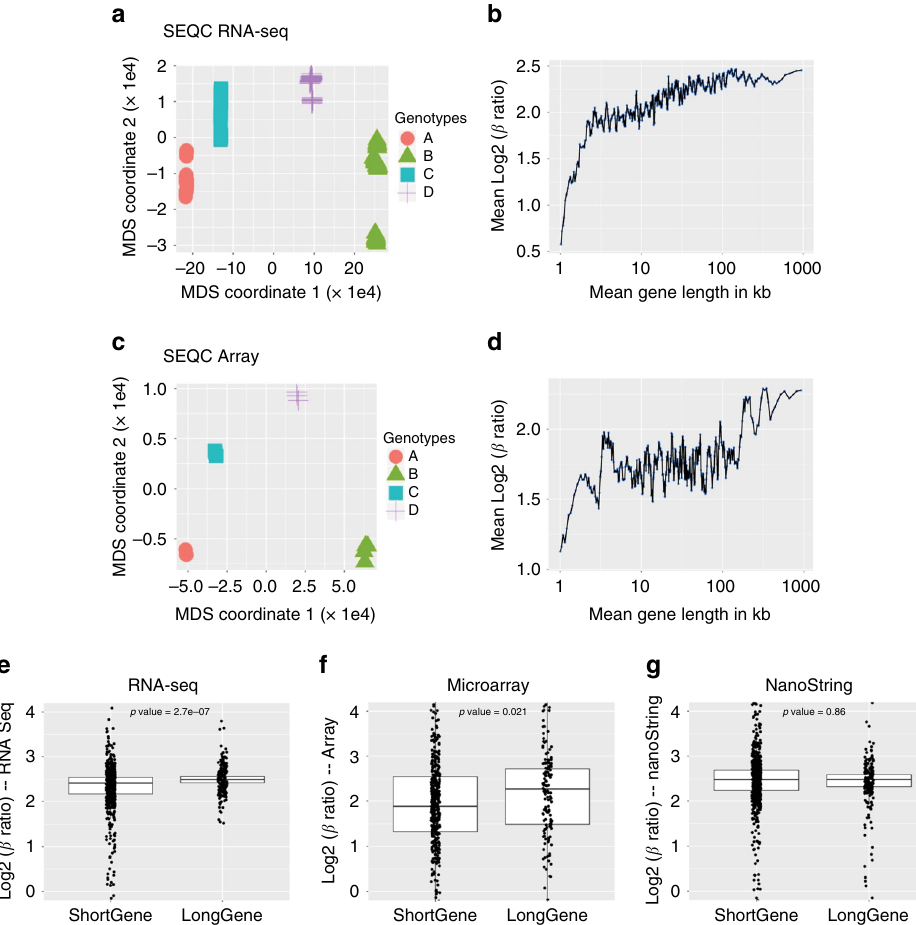
Fig. 4 A long gene bias is observed in SEQC RNA-Seq and microarray, but not in NanoString, datasets. a MDS plot using Euclidean distance on the Novartis SEQC 32 count dataset (A is Universal Human Reference RNA, B is Human Brain Reference RNA, C is a mixture of A and B at a ratio of 3:1, and D is a mixture of A and B at a ratio of 1:3). b Mean Log 2 β ratio of gene expression in the SEQC RNA-seq dataset was plotted against gene length ( β ratio = (B – A)/(C – A); n = 64 each). Each blue dot is a bin of 200 genes with shift size of 40 genes 6 . c MDS plot using Euclidean distance on the SEQC microarray dataset. d Mean Log 2 β ratio of gene expression in the SEQC microarray dataset was plotted against gene length ( n = 4 each). Each blue dot is a bin of 200 genes with shift size of 40 genes 6 . e – g Box plots of the ~680 genes that are common amongst the three different platforms. The distributions of the mean Log 2 β ratio was calculated for each of the ~680 genes in the samples and plotted for long and short genes are compared across the three platforms: ( e ) RNA-seq, ( f ) microarray, and ( g ): NanoString ( n = 6 each). P values were computed using the Wilcoxon – Mann – Whitney test. In the box plots, the center lines show medians. Box limits indicate the 25th and 75th percentiles, and whiskers extend to 1.5 times the interquartile range. See Supplementary Figs. 6 – 9 for additional analyses of the SEQC and NanoString